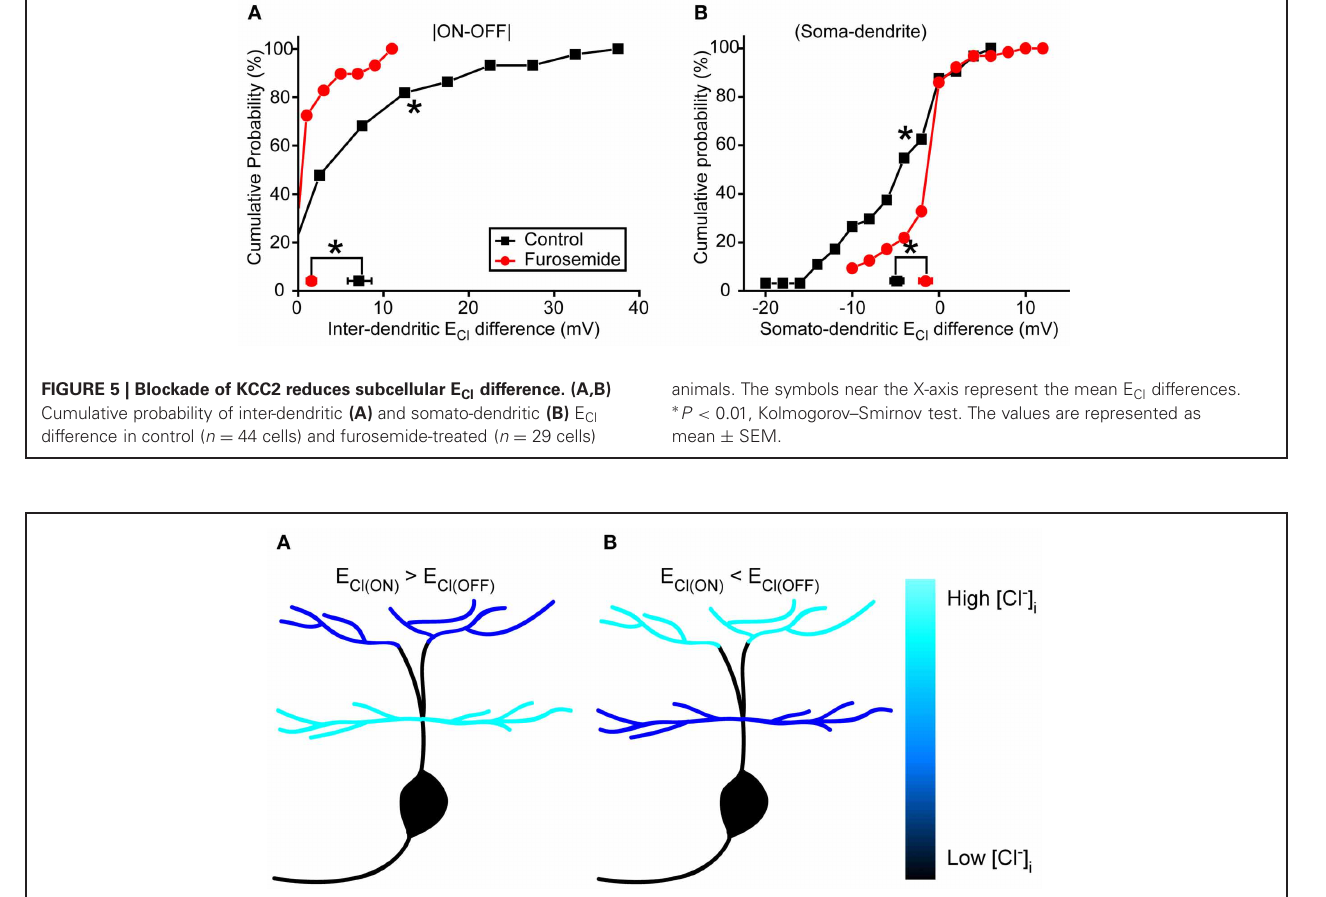
FIGURE 6 | Schematic of subcellular E Cl differences within single zebrafish RGCs. (A,B) Cartoon showing subcellular E Cl differences between soma, ON and OFF dendrites in zebrafish ON-OFF RGCs. The [Cl − ] i is color-coded.